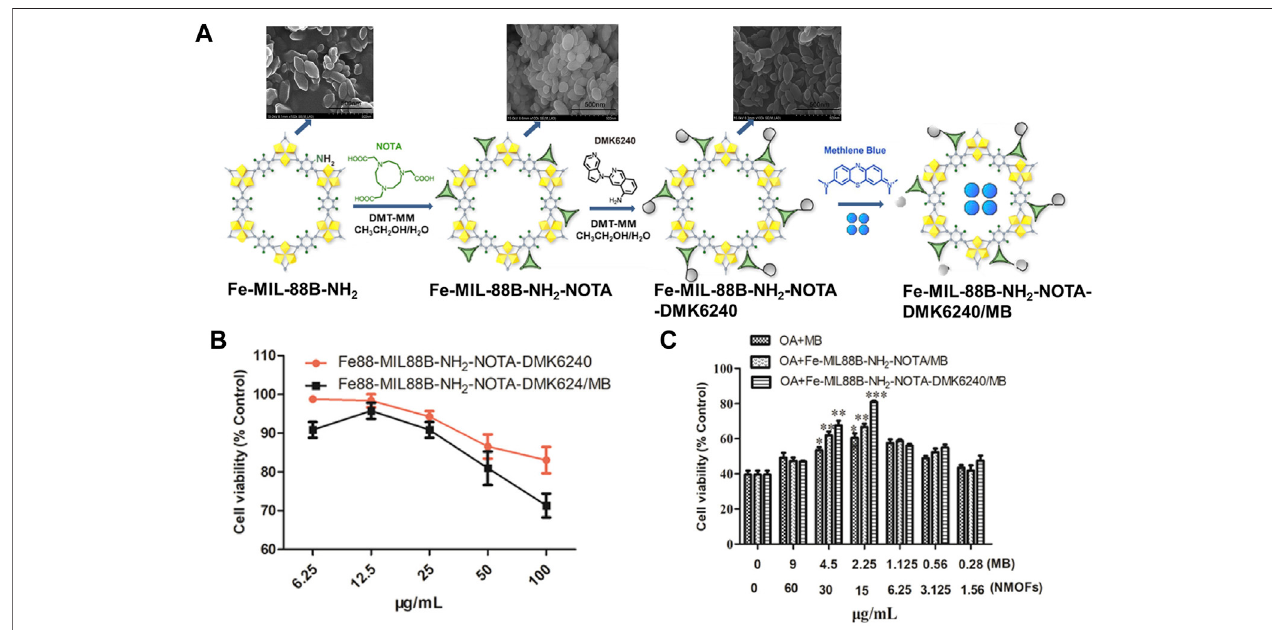
FIGURE 3 | (A) The schematic description of the synthesis process for Fe-MIL-88B-NH 2 -NOTA-DMK6240/MB. (B) Viabilities of SH-SY5Y cells cultured with Fe- MIL-88B-NH 2 -NOTA-DMK6240 and Fe-MIL-88B-NH 2 -NOTA-DMK6240/MB assessed by MTT. (C) Cytoprotection effect of Fe-MIL-88B-NH 2 -NOTA-DMK6240/MB. The OA-induced SH-SY5Y cell was treated with MB, Fe-MIL-88B-NH 2 -NOTA/MB, and Fe-MIL-88B-NH 2 -NOTA-DMK6240/MB for an additional 12 h. Source: (Zhao et al.,